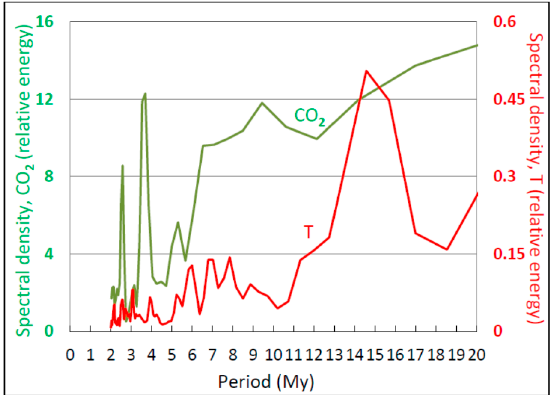
Figure 7. Spectral power periodograms of atmospheric CO 2 and temperature over the Phanerozoic Eon. The green and red curves show CO 2 and temperature spectral density profiles, respectively. The temperature periodogram was constructed using detrended temperature proxy data. Time periods covered and (in parentheses) Fisher’s Kappa and the corresponding probability that the atmospheric CO 2 concentration and T periodograms result from white (Gaussian) noise are 85 to 0 My (12.57, 1.96 × 10 − 5 ) and 522 to 0 My (28.98, 2.0 × 10 − 13 ), respectively.